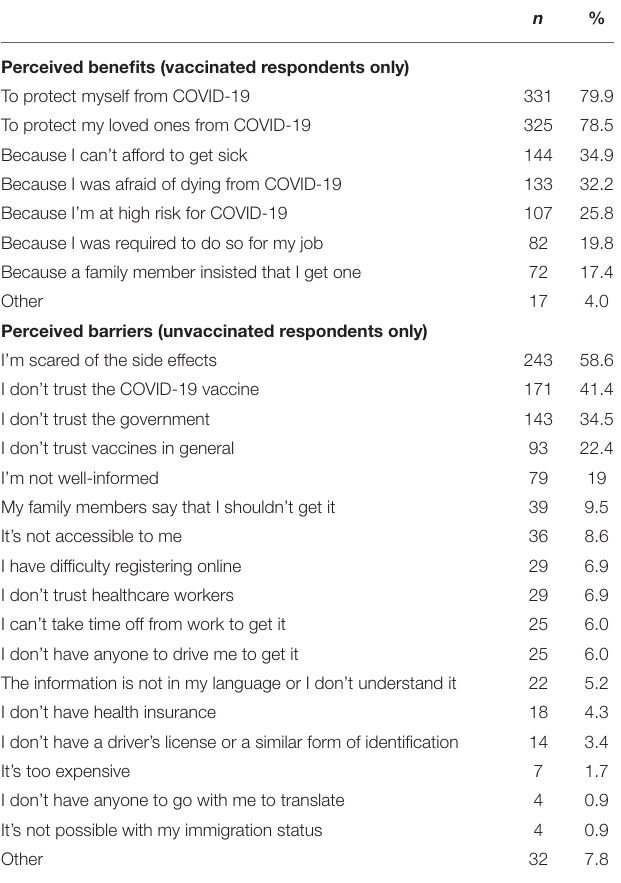
TABLE 2 | Perceived benefits and barriers of vaccination.